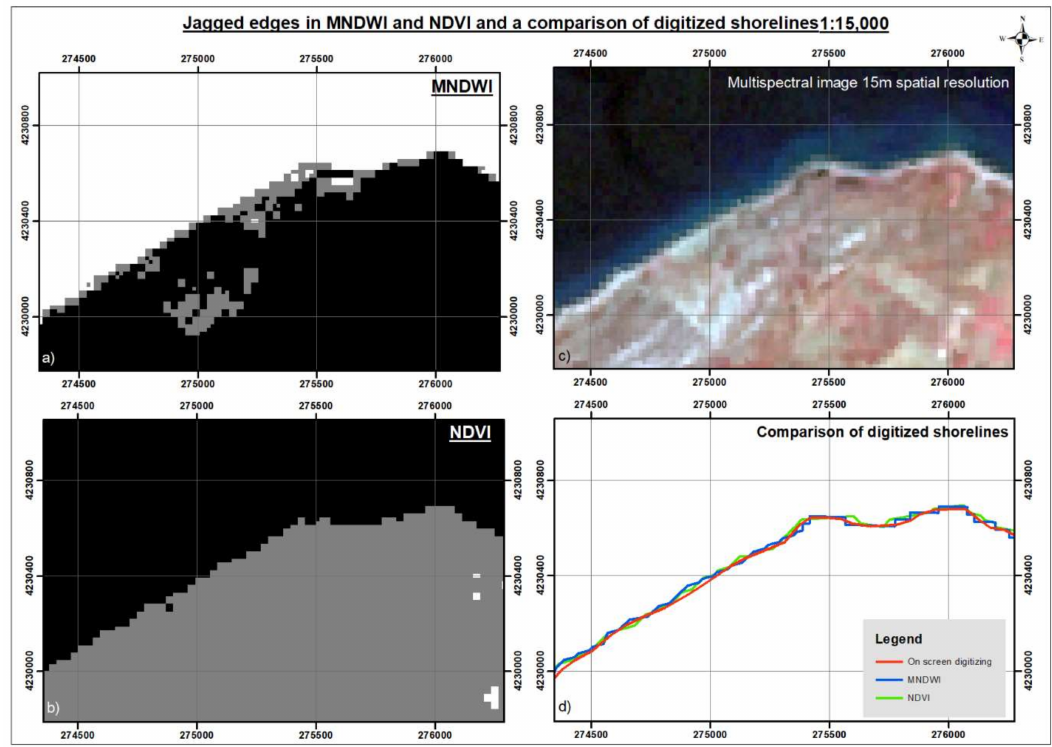
Figure 3. Jagged edges of the Landsat-derived shoreline in comparison to that derived using the on-screen digitizing method (red line). ( a ) An example of MNDWI index. ( b ) An example of NDVI index. ( c ) An example of Landsat multispectral image derived through HCS fusion algorithm. ( d ) Overlapping of digitized